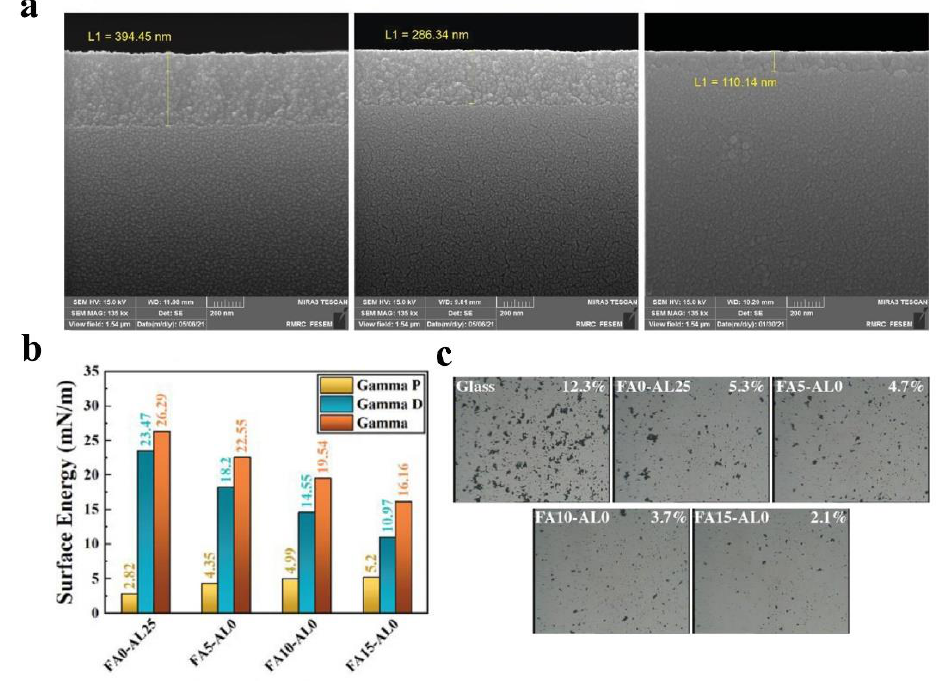
Figure 8. ( a ) SEM images of the cross-section of the coated glass. ( b ) Surface energy of the coating and ( c ) optical micrographs after dust-fall experiments, reproduced with permission from Ref.